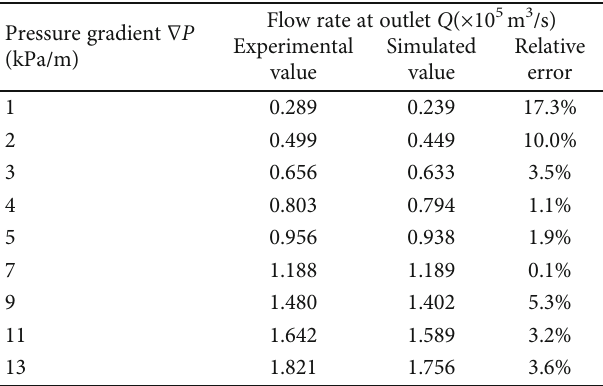
Figure 8: 3-dimensional numerical model of sample S1 with rough surface. Table 2: Comparison of fl ow rate between the experiments and numerical simulation of specimen